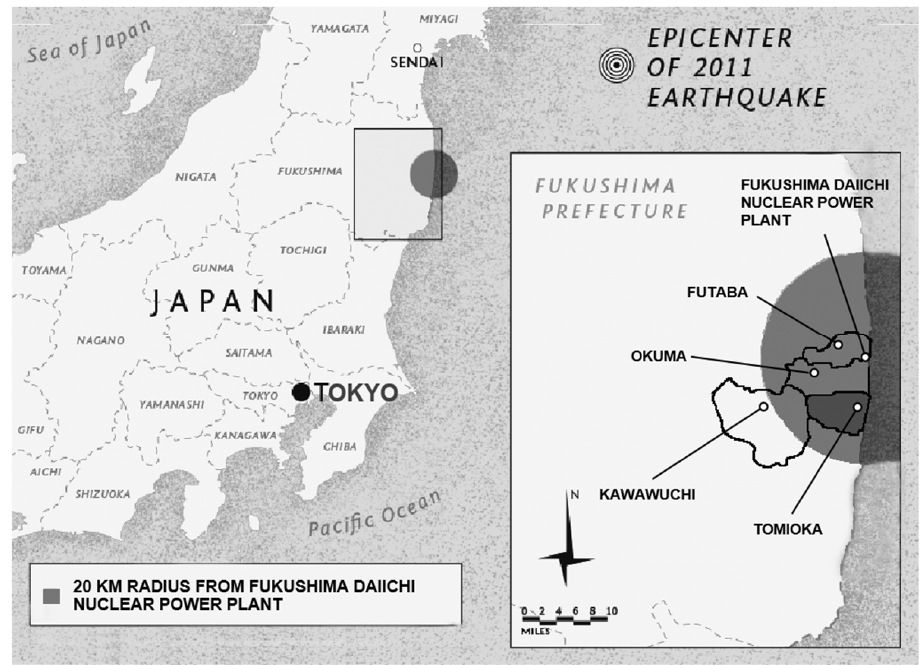
Figure 1. Map of the Fukushima prefecture showing the 20 km radius of the Fukushima Daiichi Nuclear Power Plant.